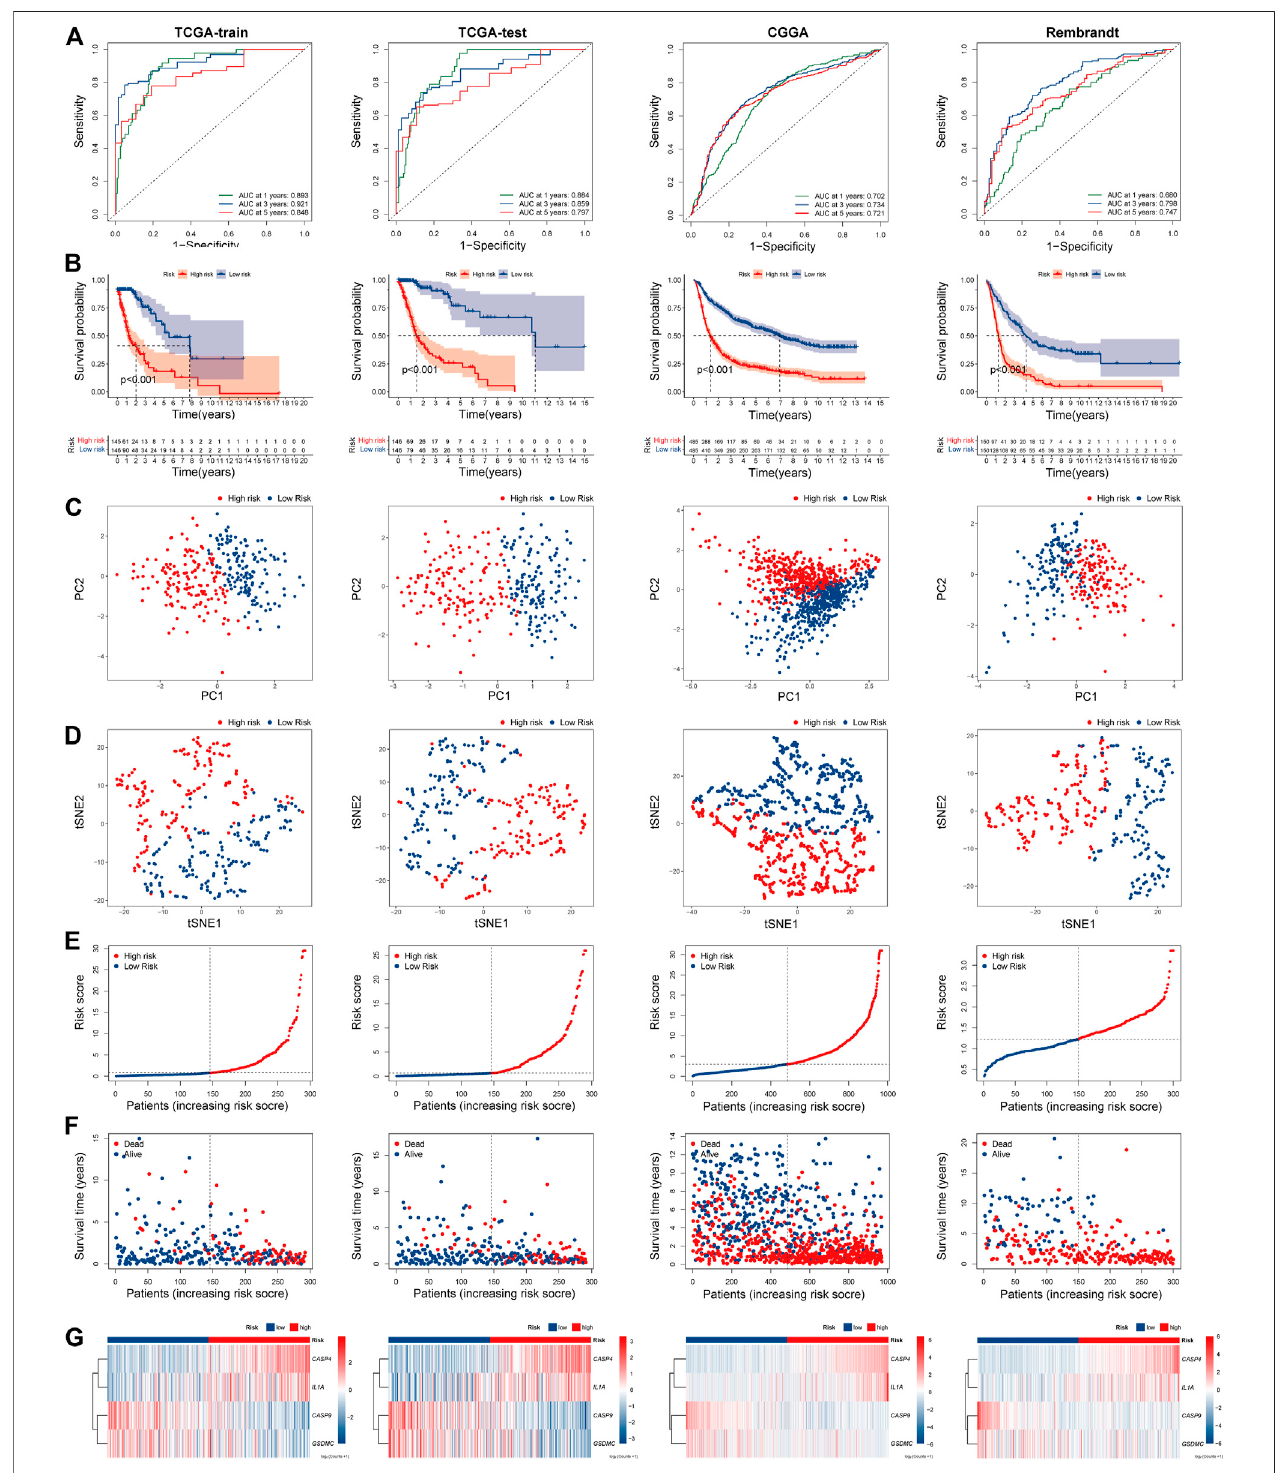
FIGURE4| PrognosticriskmodelanalysisofPRGssignatureinTCGA-train,TCGA-test,CGGA,andRembrandtdatasets. (A) Thetime-dependentROCanalyses of the PRGs risk score in TCGA-train, TCGA-test, CGGA, and Rembrandt datasets. (B) Survival curve of the PRGs signature risk model in above datasets. (C) PCA analysis of the PRGs signature in above datasets. (D) t-SNE analysis of the PRGs signature in above datasets. (E) The distribution and median value of the PRGs signature risk scores in above datasets. (F) The distributions of survival status, survival time, and PRGs risk score in above datasets. (G) Heatmap of PRGs signature expression in high- and low- risk groups in above datasets. REMBRANDT, Repository of Molecular Brain Neoplasia Data. PRGs, Pyroptosis Related genes. ROC, receiver operating characteristic; TCGA, The Cancer Genome Atlas. CGGA, Chinese Glioma Genome Atlas. PCA, Principal components analysis. t-SNE, t-Distributed Stochastic Neighbor